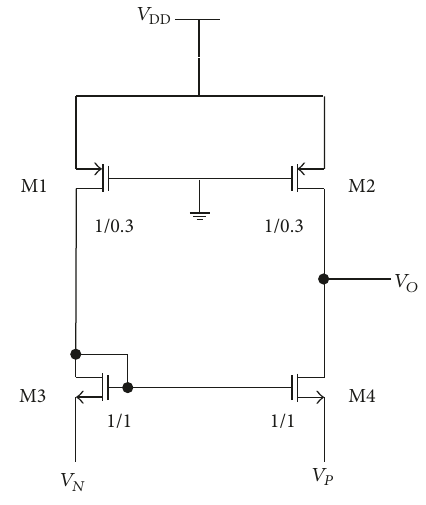
Figure 5: Single supply op-amp.